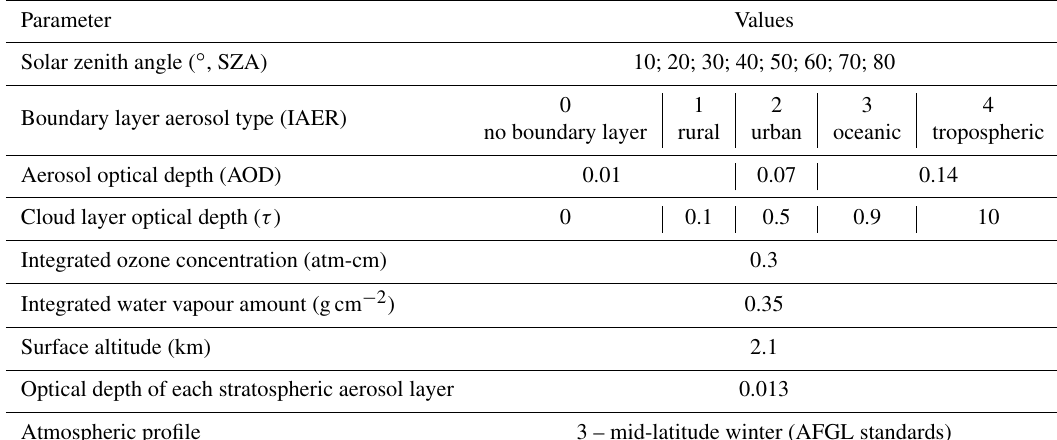
Table 2. Atmospheric parameters of simulations. Each irradiance profile is calculated for eight values of the SZA, five values of IAER, three values of the AOD, and five values of τ (one for clear-sky conditions, three for partially cloudy conditions, and one for full overcast conditions). The other parameters are fixed in the SBDART